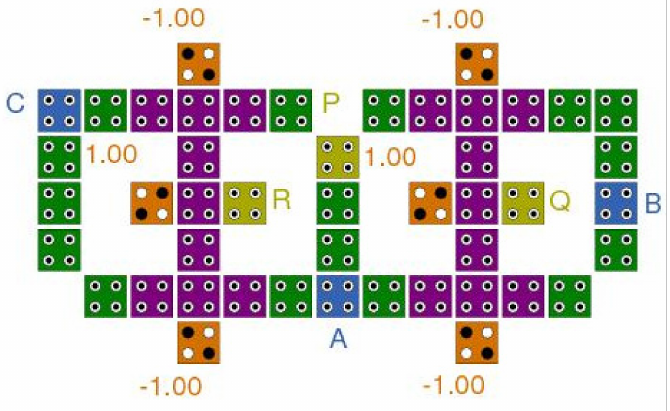
Figure 7. The proposed design of the double Feynman gate based on majority gates.